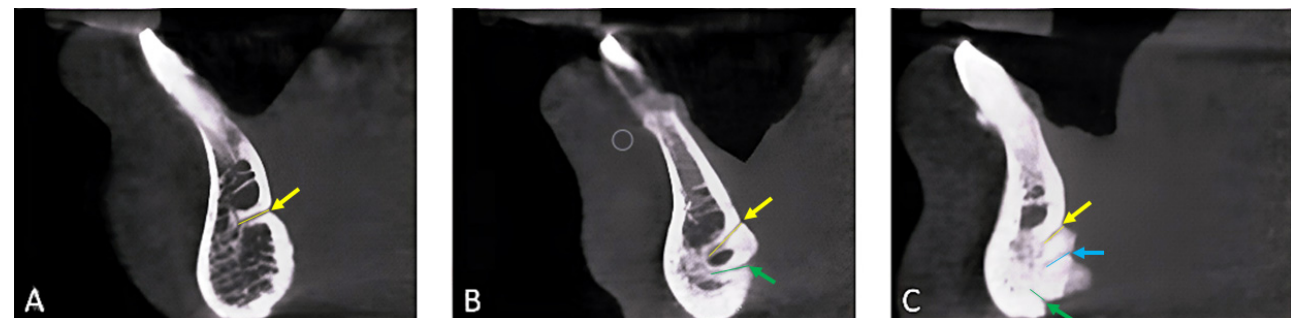
Figure 3. Sagittal view at the mandibular lingual canal/s of CBCT scan showing three different variations, ( A ) single, ( B ) double, ( C ) triple canals. The yellow arrow points to the supra-spinosum foramen, which is the opening of its corresponding canal (i.e., yellow line). The blue arrow points to the inter-spinosum foramen, which is the opening of its corresponding canal (i.e., blue line). The green arrow points to the infra-spinosum foramen, which is the opening of its corresponding canal (i.e., green line).